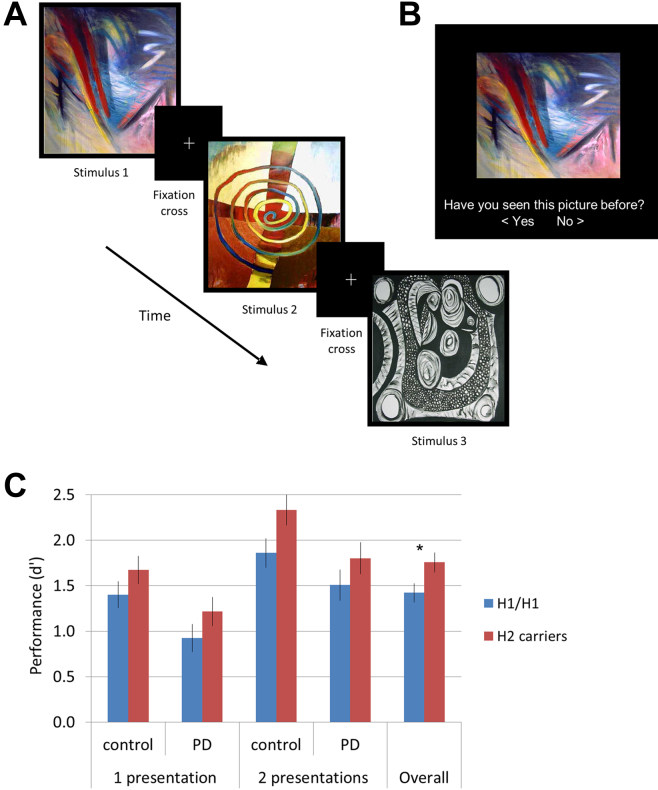
The abstract pictures memory encoding task. (A) A typical series of stimuli. (B) A typical presentation in the post-scanner test of recognition. Participants responded using the arrow keys on the keyboard. (C) Performance on the post-scanner test of recognition. d’ scores are shown (higher score represents greater discrimination during recognition memory). Group means are plotted. Error bars indicate ± 1 SEM. Asterisk denotes p < 0.05 based on main effects of repeated measures ANOVAs. There were additional significant effects of the number of presentations and disease status (PD patients vs. control subjects). Abbreviations: ANOVA, analysis of variance; PD, Parkinson's disease; SEM, standard error of the mean.